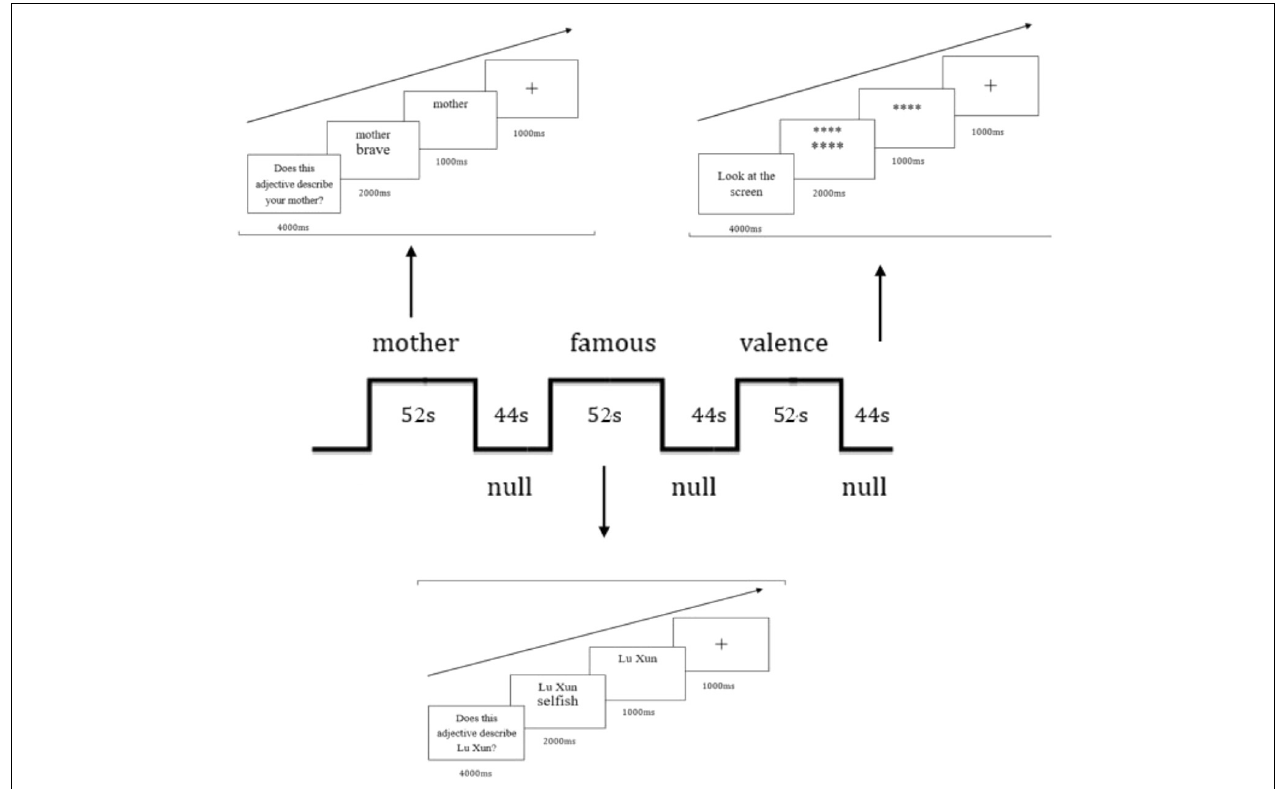
FIGURE 1 | Illustration of stimuli and procedure during relational-self scans. Each scan consisted of three sessions of different judgment tasks. Two successive sessions were intervened by a null session of 44 s.